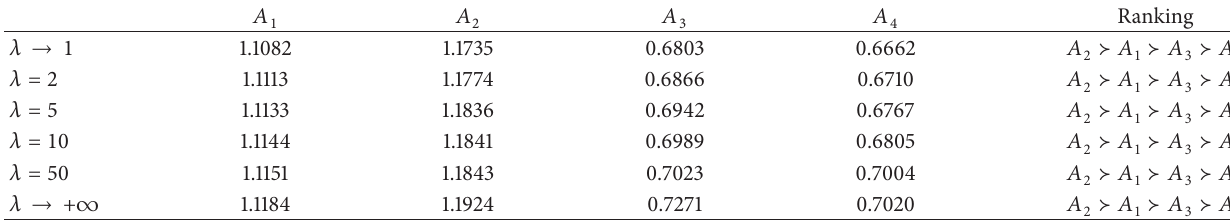
Table 7: Score values obtained by the TIT2FFWG operator and the rankings of alternatives.